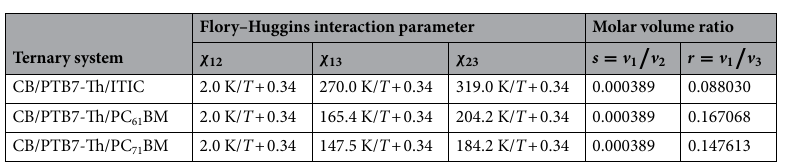
Table 2. Flory–Huggins interaction parameters and molar volume ratios for the ternary systems: PTB7-Th’s M n = 300